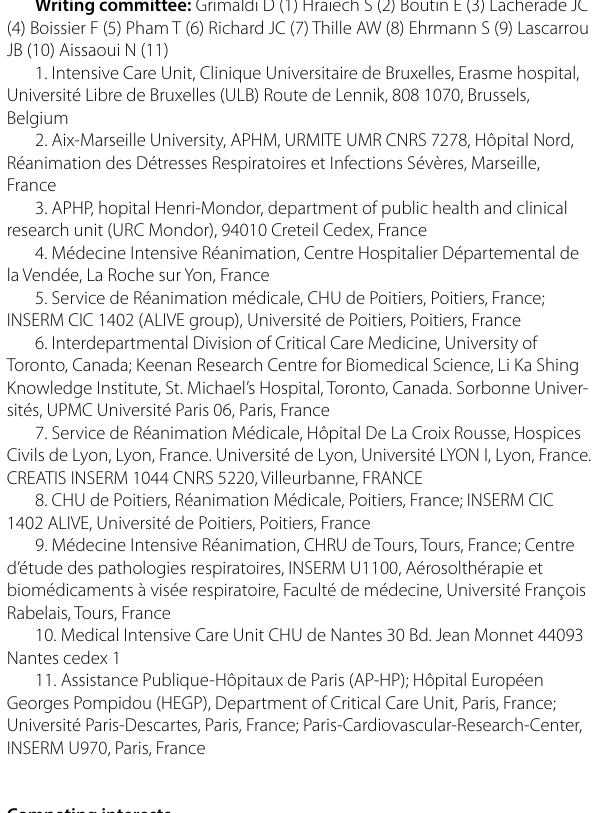
Additional file 1: Table S1. List of contributors; Table S2. Patients’ characteristics according to the presence of hypoxemia; Table S3. ARDS exclusion criteria among patients with bilateral infiltrates; Table S4. ICU mortality according to ventilator support and hypoxemia class; Table S5. Univariate analysis of variables associated with mortality in hypoxemic patients; Table S6. aHRs of PaO2 / FiO2 banding in different